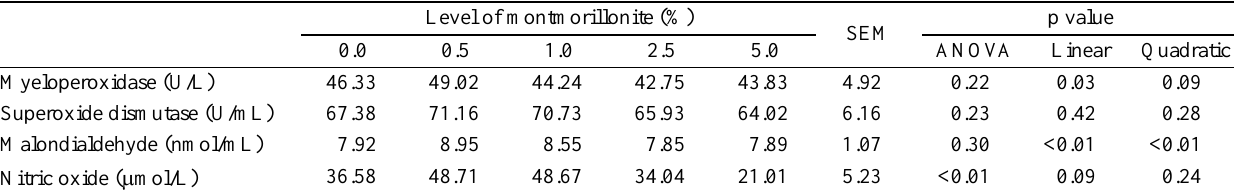
Table 4. Plasma indicators of oxidative stress in weaned pigs fed diets containing graded levels of montmorillonite (d 28) 1